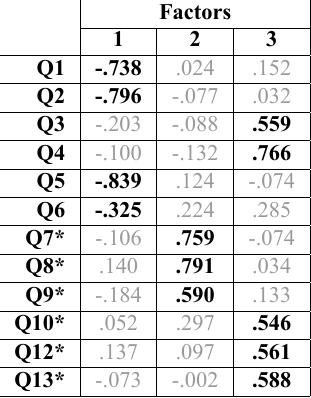
Q7. Você sentiu desconforto durante a sua experiência com o sistema? Q8. Você sentiu tontura ou náusea durante a prática com o sistema? Q9. Você sentiu desconforto ocular durante a prática com o sistema? Q10. Você se sentiu confuso ou desorientado durante sua experiência com o sistema? Q12. Você achou a tarefa difícil? Q14. Se você se sentiu desconfortável durante a tarefa, indique as razões. Resposta aberta